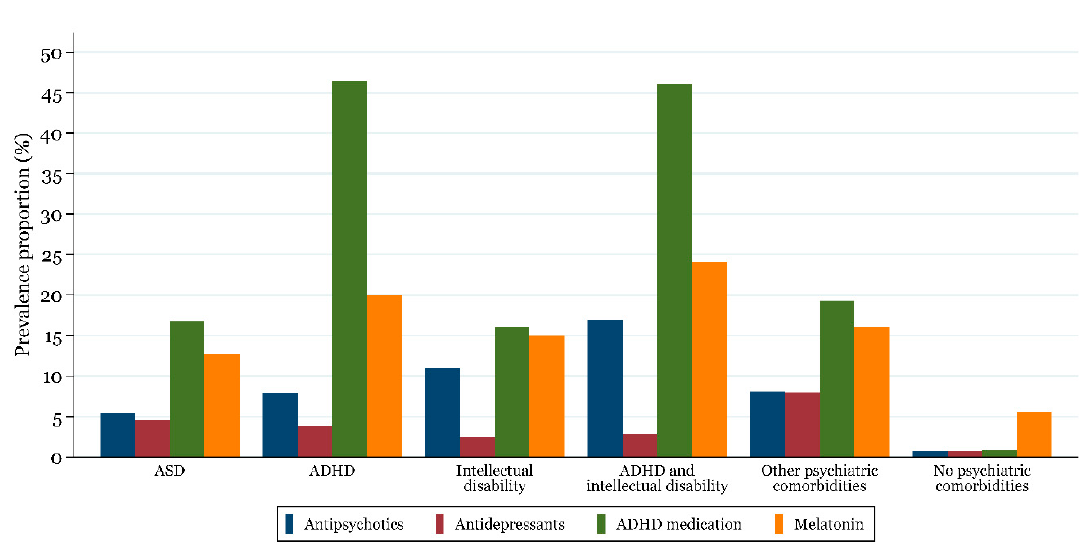
Figure 3. One-year prevalence proportion for the use of ADHD medication, antidepressants, antipsychotics, and melatonin in 2017 in children and adolescents 6–17 years old with ASD by psychiatric comorbidity.